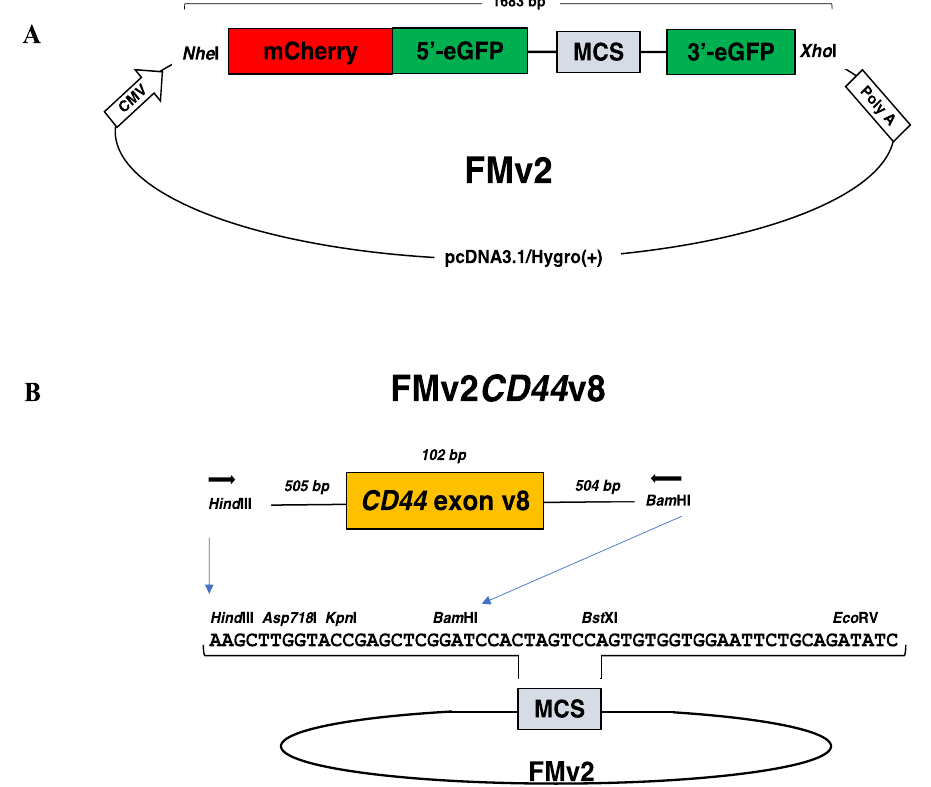
Figure 1. Dual fluorescence-based splicing reporter minigenes. ( A ) The structure of a ready-made dual fluorescence-based splicing reporter minigene is schematically described. An expression vector pcDNA3.1 / Hygro( + ) encoding the CMV promoter (CMV) and the polyadenylation signal of bovine growth hormone gene (poly A) was inserted with the synthesized 1683 bp long fragment with the use of Nhe I and Xho I restriction enzymes. The synthesized DNA comprised of sequences of the Nhe I restriction enzyme recognition site, mCherry, the 5 ′ region of eGFP (5 ′ -eGFP), the 5 ′ -end of DMD